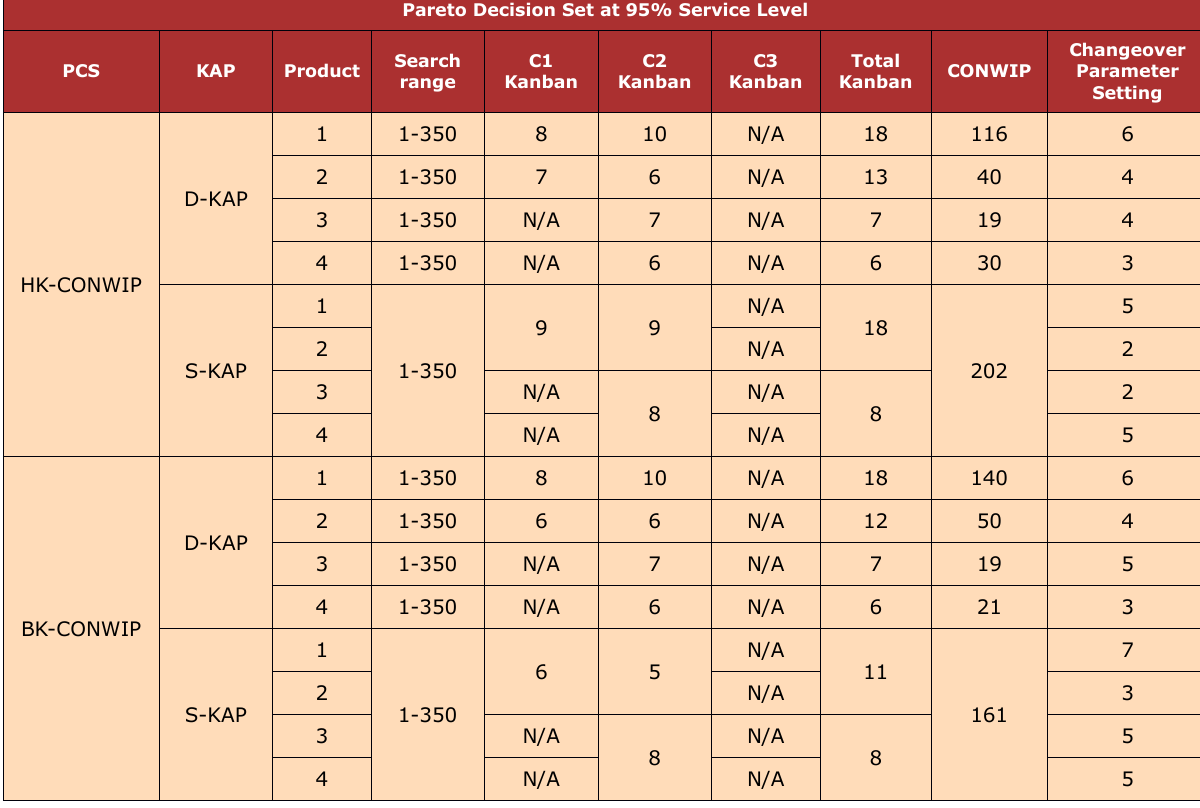
Table 6. Case-2 Search space and optimal values of PCS+KAP at 95% service